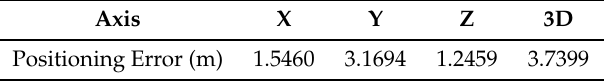
Table 2. Dynamic positioning errors.